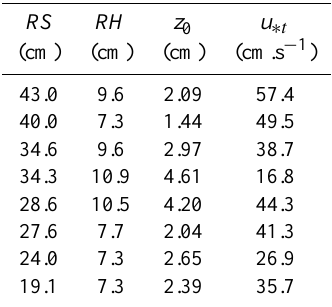
Table 3. Calculated wind friction threshold velocities for aeolian erosion for the eight experimental ridge